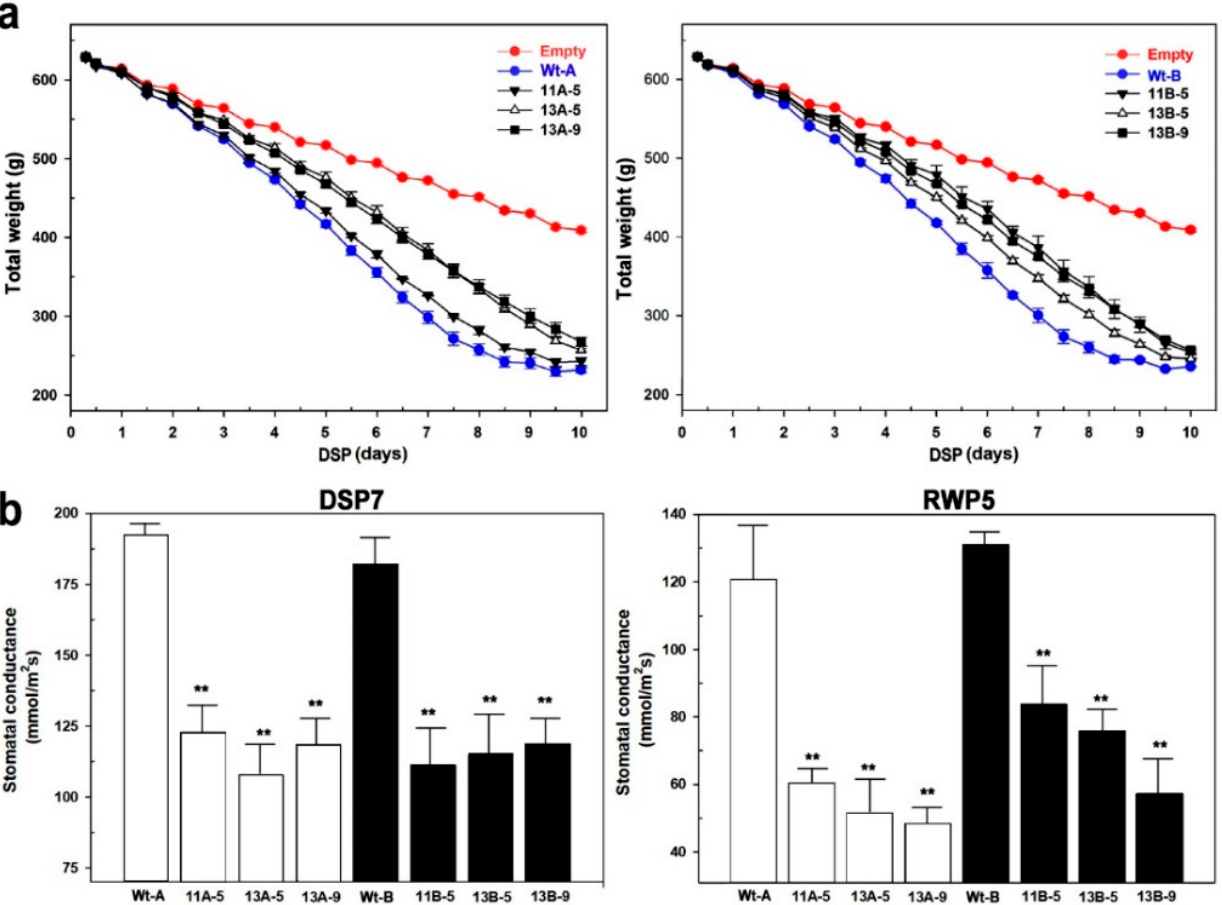
Figure 4. Water loss and stomatal conductance of OsPYL/RCAR7 -OX transgenic maize lines under drought-stress conditions. ( a ) Changes in the total weight of pots with seedlings (pots containing wild-type or OsPYL/RCAR7 -OX seedlings) from DSP0 to DSP10. ( b ) Stomatal conductance of wild- type and OsPYL/RCAR7 -OX seedlings at DSP 7 and RWP 5. Bars represent the means ± SE of three replicates. Asterisks represent significant differences from the wild type (**, p -value < 0.01). DSP, drought-stress phase; RWP, rewatering phase; Wt, untransformed wild-type plants; and 11A-5 to 13B-12, selected transgenic lines.